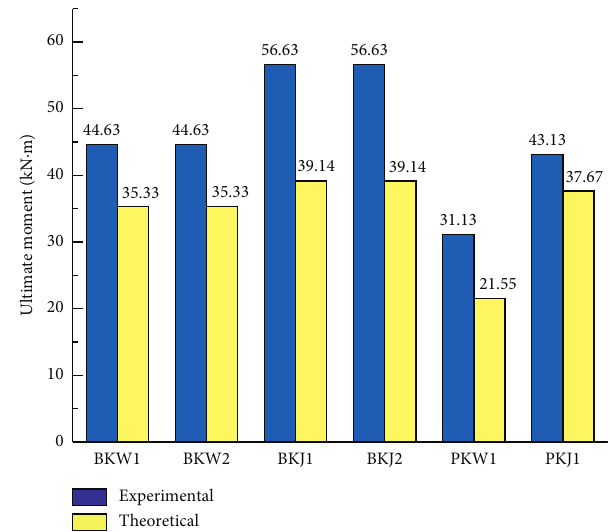
Figure 10: Comparison between experimental and theoretical ultimate moments.